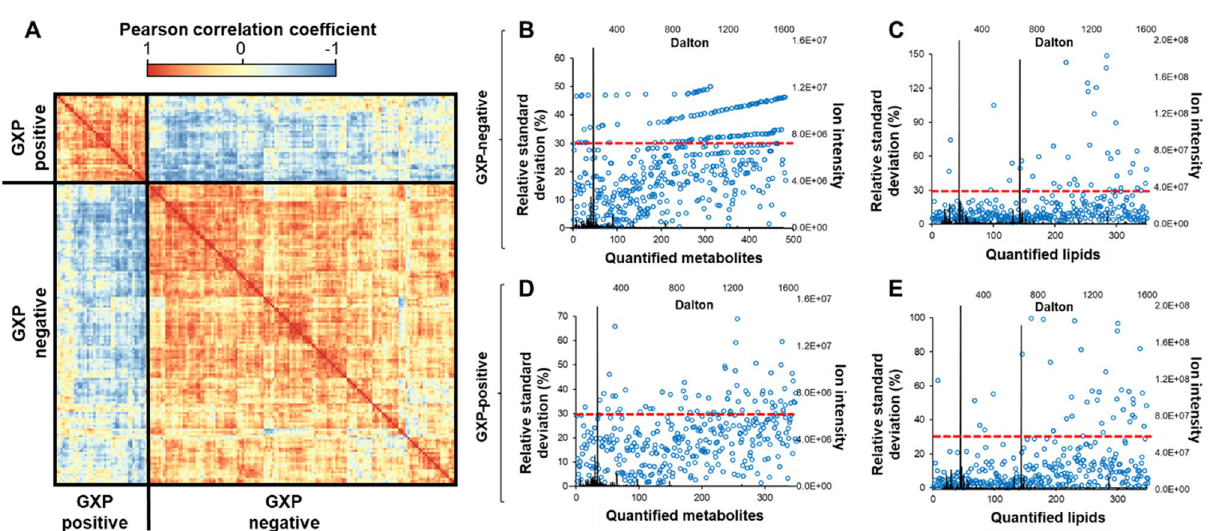
Figure 4. Overview of study participant correlation and individual feature deviations. ( A ) Global correlation heatmap of study participants. Distribution of relative standard deviation values of metabolites and lipids in ( B , C ) GXP-negative and ( D , E ) GXP-positive study participants. The red dashed lines indicate 30% relative standard deviation